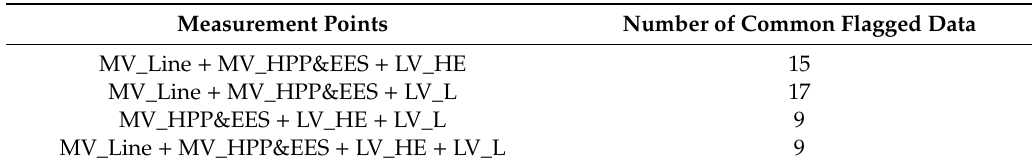
Table 6. Limit values of standard EN 50160 [121] used to the global index.